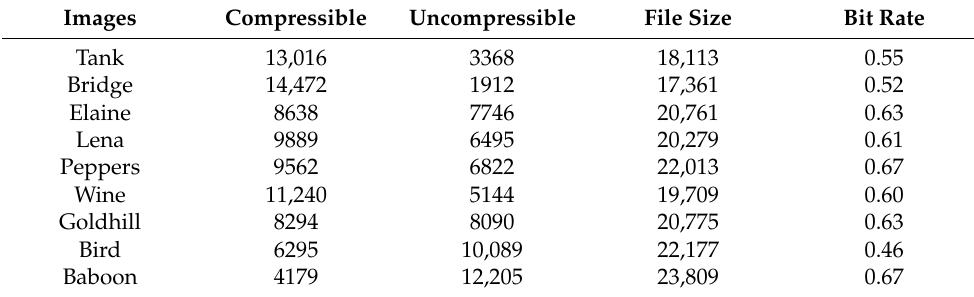
Table 3. Number of SOC compressible and uncompressible blocks.